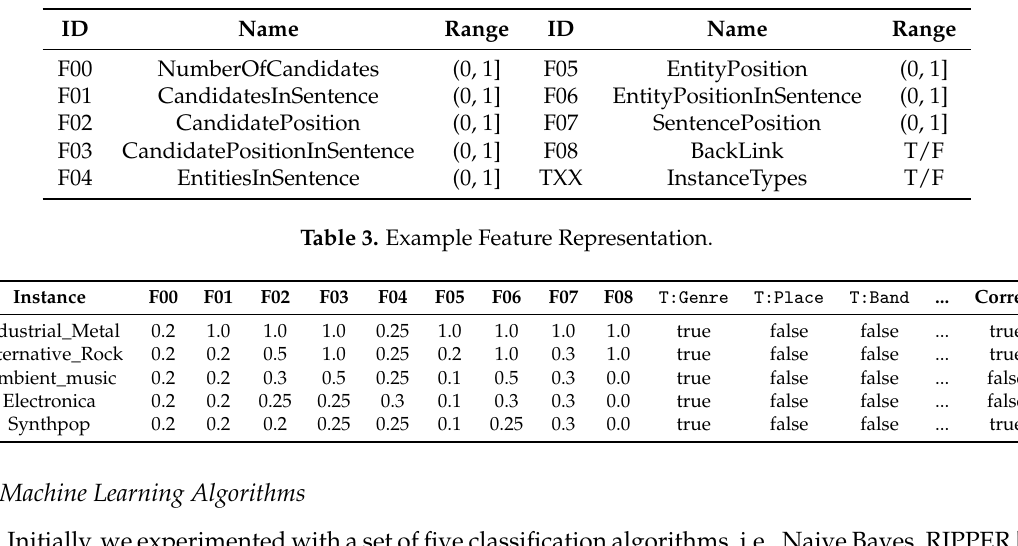
Table 2. List of features used by the classifier.